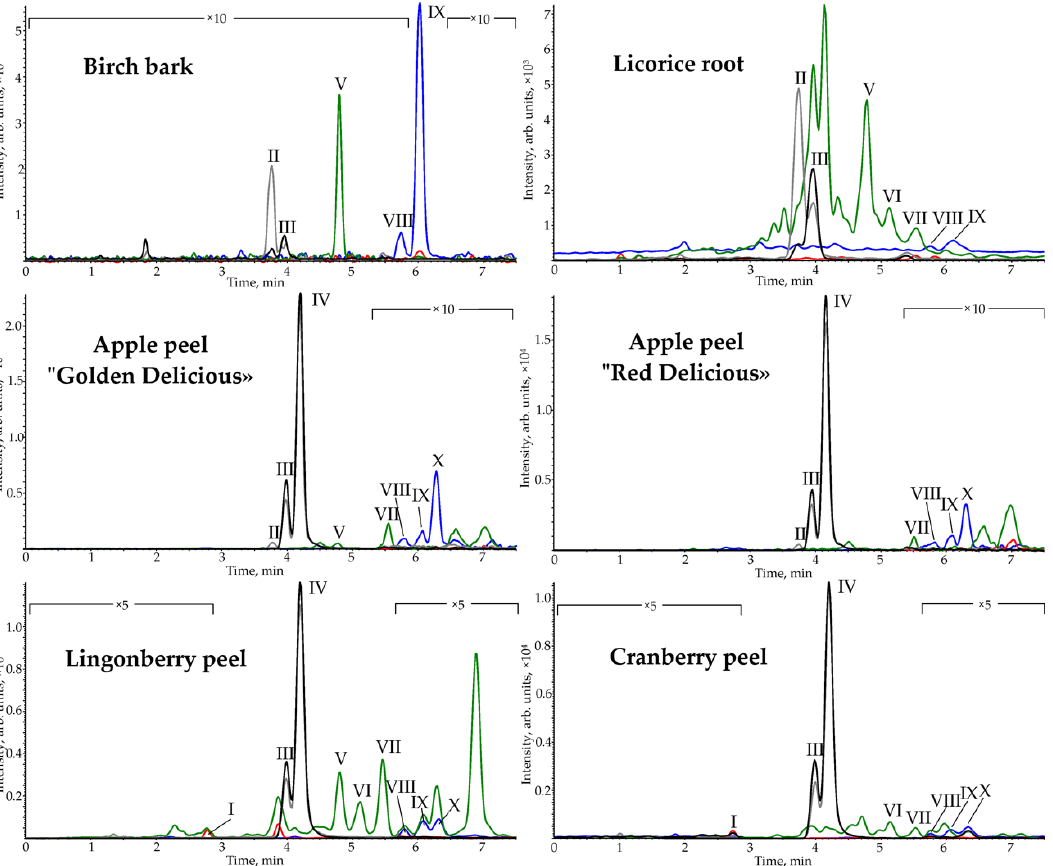
Figure 4. SFC ‐ APCI ‐ MS/MS chromatograms of plant methanolic PLE extracts on HSS C18 SB sta ‐ Figure 4. SFC-APCI-MS/MS chromatograms of plant methanolic PLE extracts on HSS C18 SB tionary phase. stationary